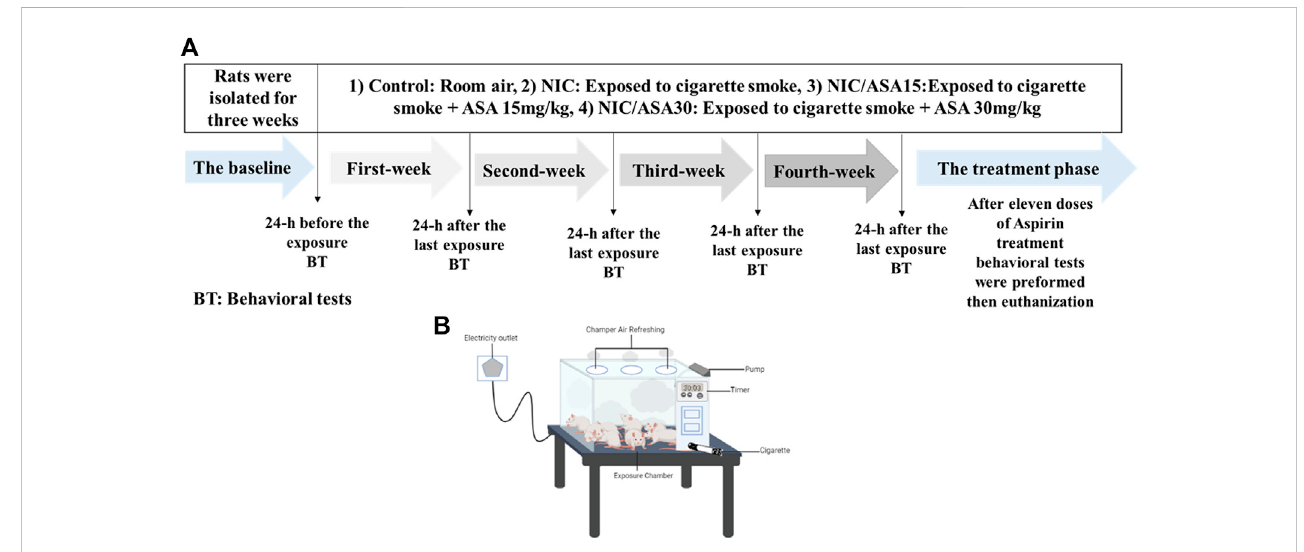
FIGURE 1 (A) Experimentaltimelineforcigaretteexposure,ASAtreatmentandbehavioraltesting; (B) Diagramillustrating theapparatususedforcigaretteexposure